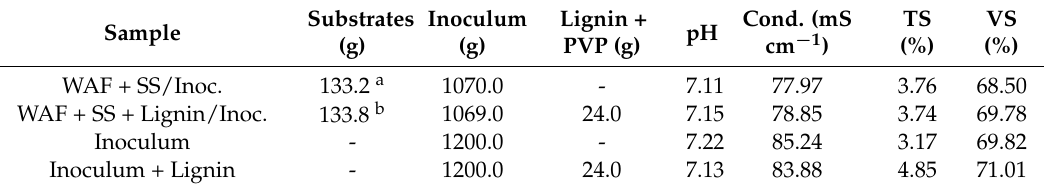
Table 1. Composition and selected properties of the